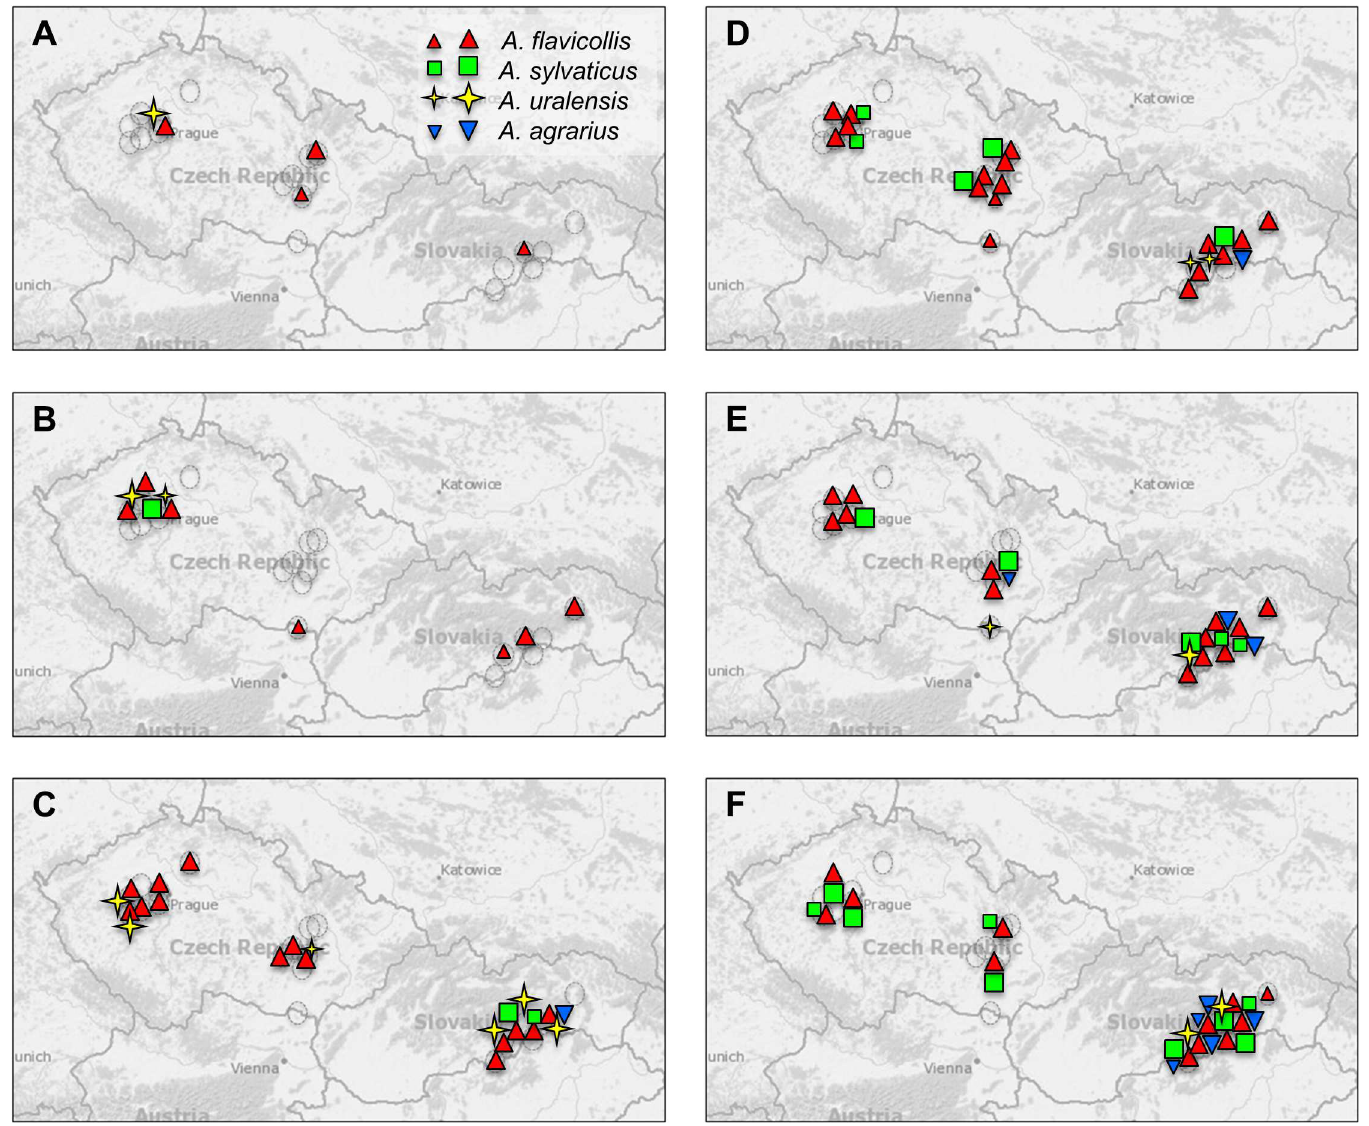
Fig 8. Graphicalrepresentation of postglacial recolonizationby the genus Apodemus in CentralEurope (A-Late Vistulian, B-Preboreal, C-Boreal, D-Atlantic, F-Late